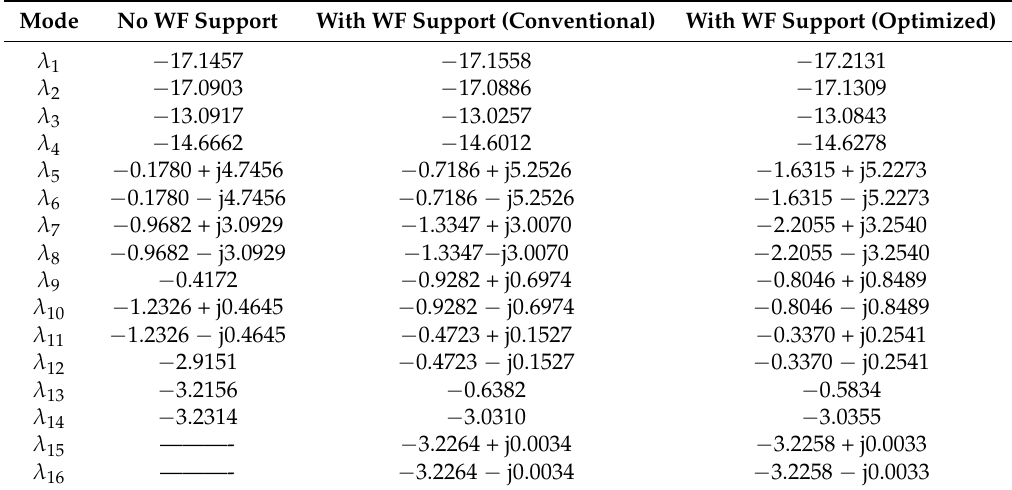
Figure 10. Eigenvalue plot of two systems. Table 2. Comparison of eigenvalues.